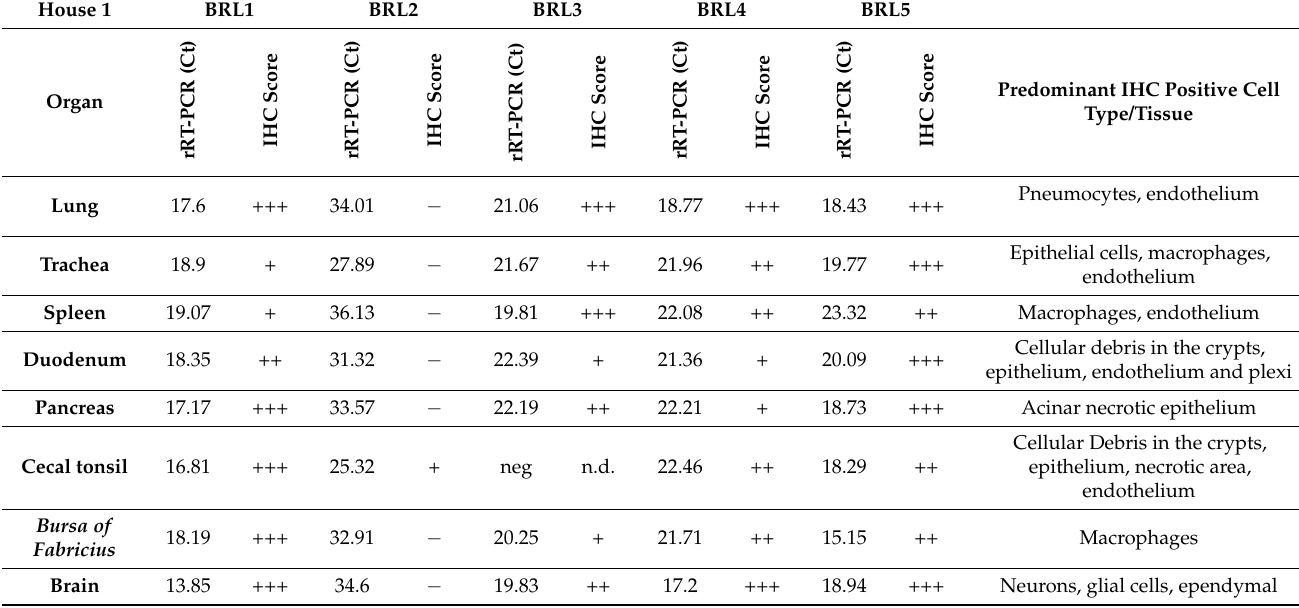
Table 2. AIV rRT-PCR (Ct) results and IHC score of organs collected from dead birds of house